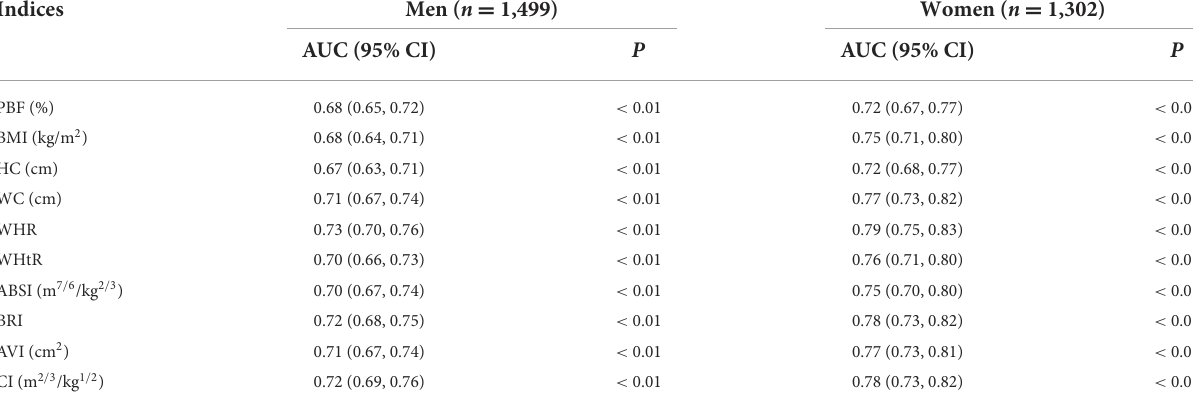
TABLE 3 The AUC of 10 types of ORI for predicting